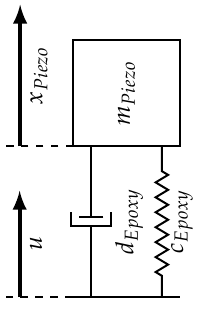
Figure7. Spring-Mass-Damper-ModelofPiezo-actuatorandEpoxy Table1. MaterialParameters[15,16]